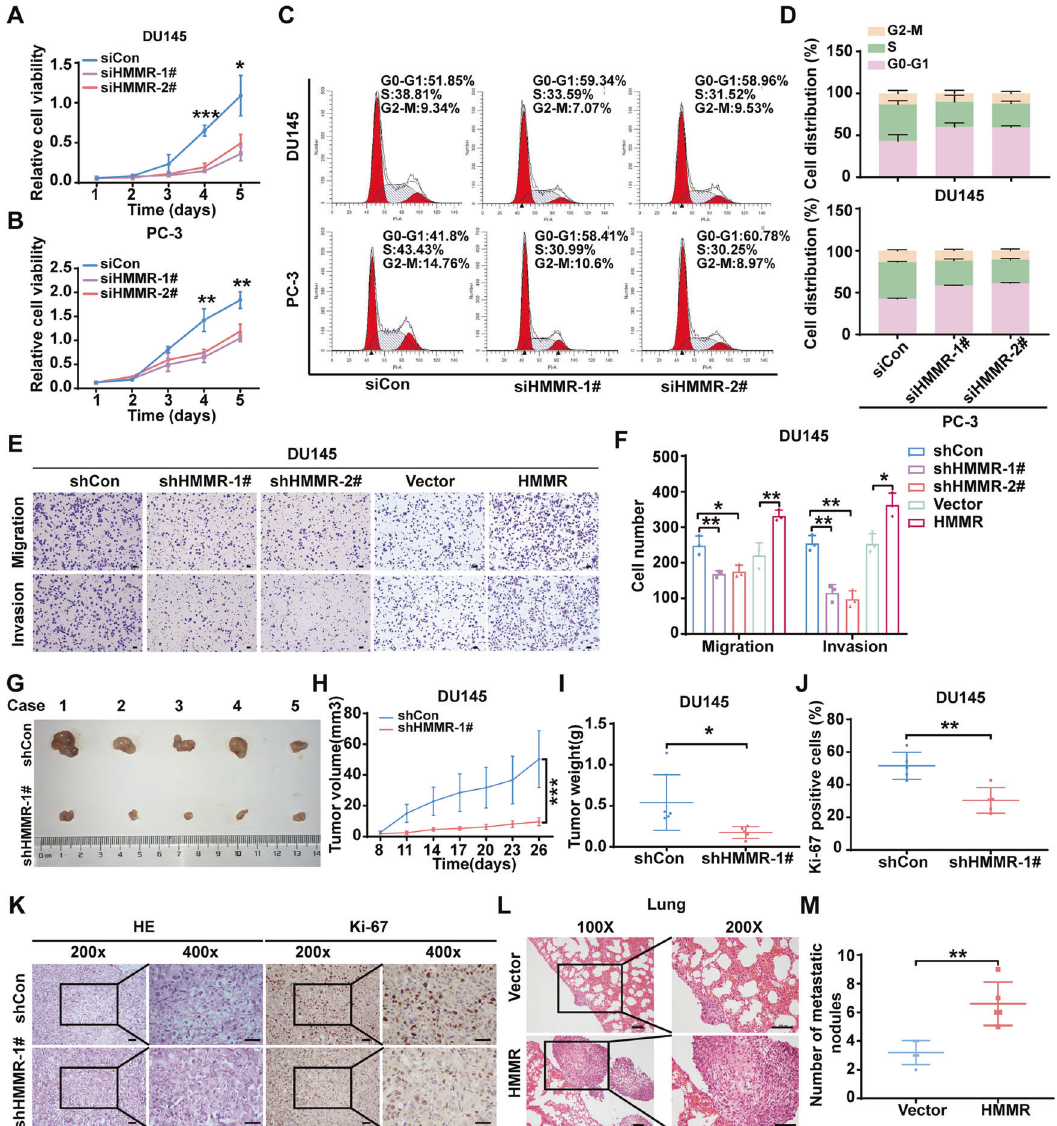
respectively. G Gross observation of subcutaneous tumours. H Analysis of tumour volumes of the HMMR knockdown or control group recorded every three days. I Analysis of tumour weight of the HMMR knockdown or control group. J , K Quantitative analysis and representative IHC analysis of Ki-67-positive cells and HE staining derived from the shCon and shHMMR-1# groups, scale bar: 100 μ m. L . HE staining of lung derived from metastasis model. M Analysis of metastatic nodules from the excised lungs of xenograft metastatic models. Data were presented as mean ± SD. * p < 0.05, ** p < 0.01, *** p <